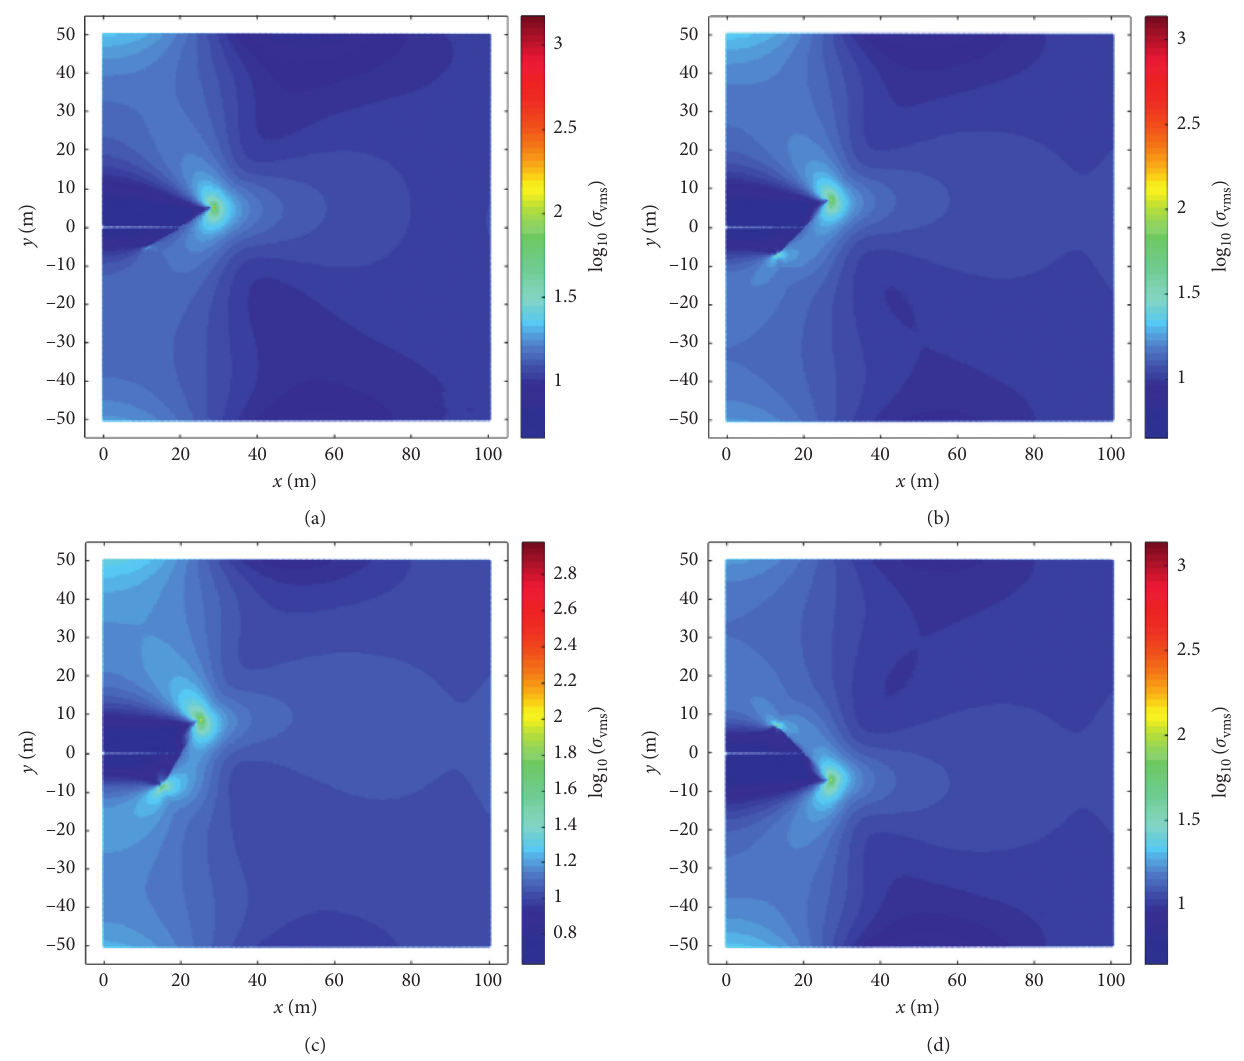
Figure 8: Von Mises stress field under different natural fracture azimuth conditions. (a) von Mises stress (step � 3), 30 ° . (b) von Mises stress (step � 3), 45 ° . (c) von Mises stress (step � 3), 60 ° . (d) von Mises stress (step � 3), 135 ° .